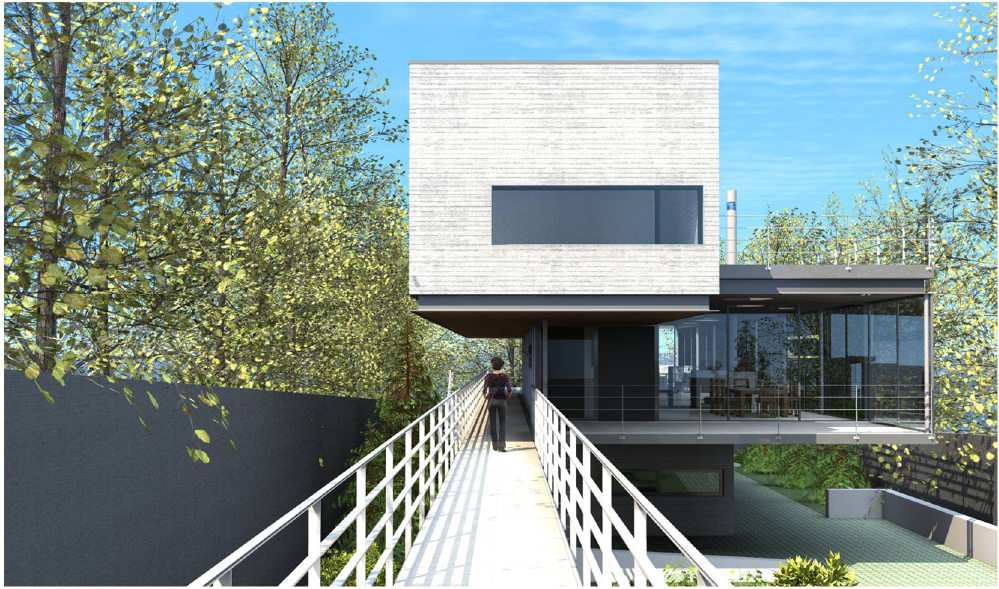
Figure 8. 3D Modeling and rendering. Mathias Klotz, Casa Ponce—Martínez San Isidro, Buenos Aires (student Nilo